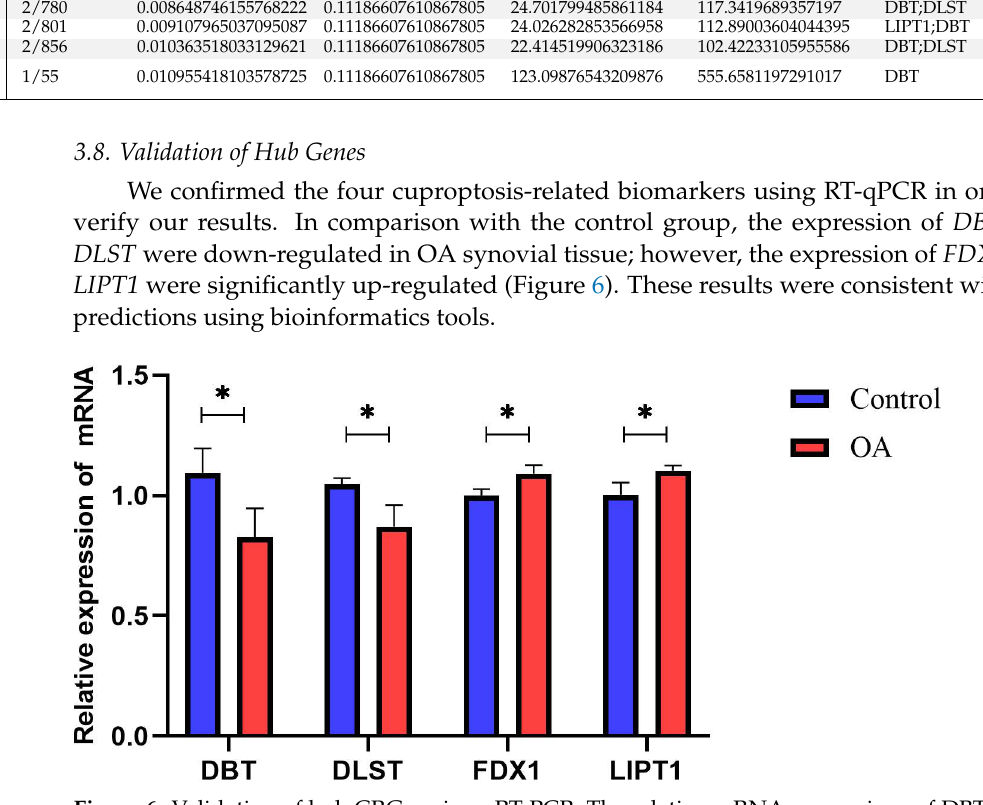
Figure 6. Validation of hub CRGs using qRT-PCR. The relative mRNA expressions of DBT, DLST, FDX1, and LIPT1 were displayed (* represents p <